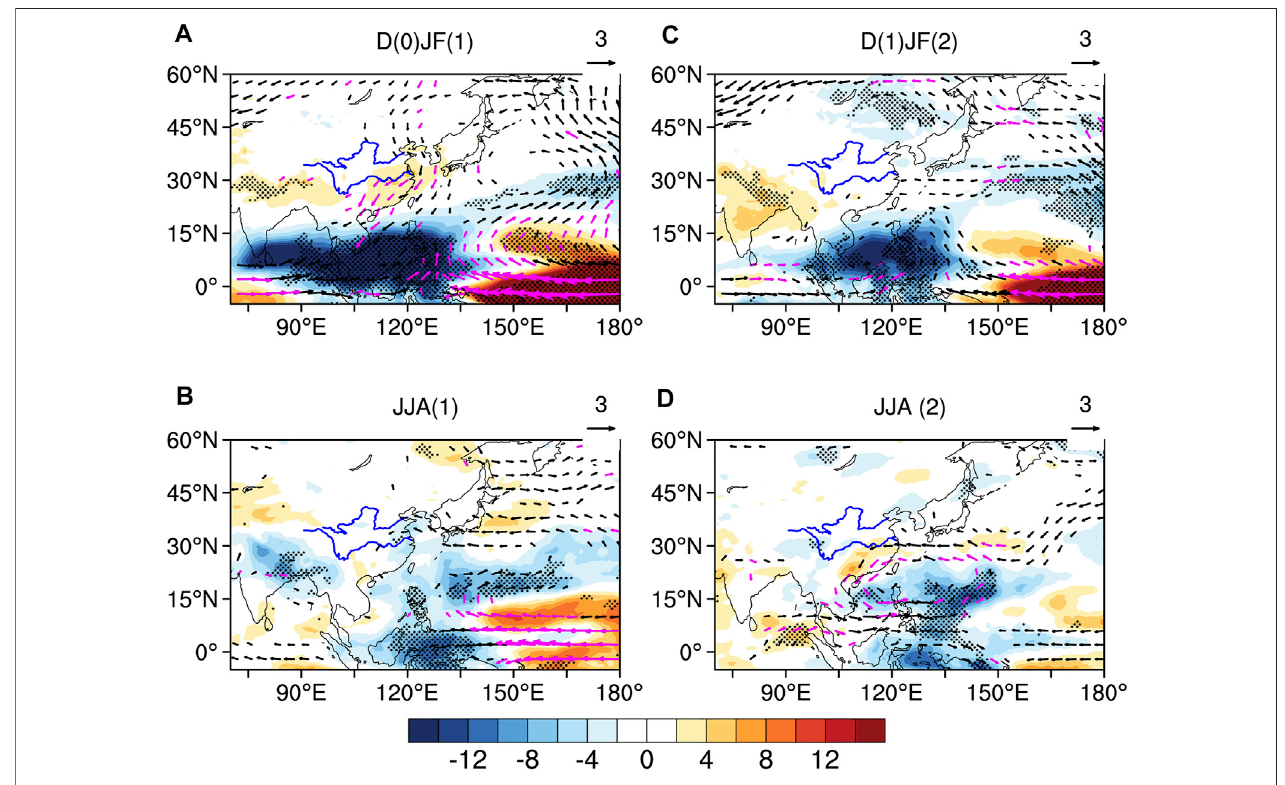
FIGURE 5 | Composites of outgoing longwave radiation (shaded, units: W/m 2 ) and 850hPa wind anomalies (vector, units: m/s) during (A) D (0) JF (1), (B) JJA (1), (C) D (1) JF (2), and (D) JJA (2). Dotted areas and purple vectors indicate values exceeding the 90% con fi dence level determined using a two-tailed Student ’ s t test.